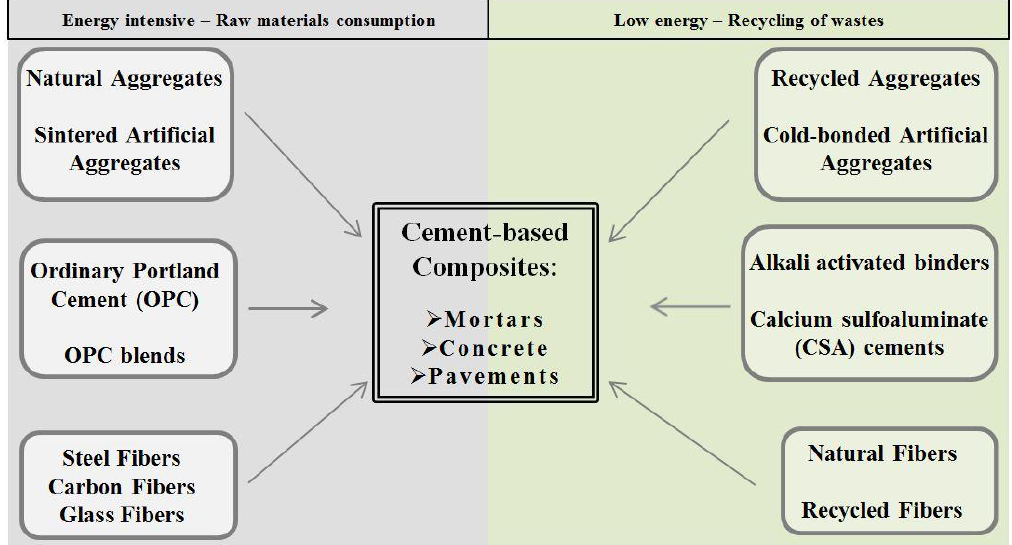
Figure 1. Components of cementitious composites in a sustainable design